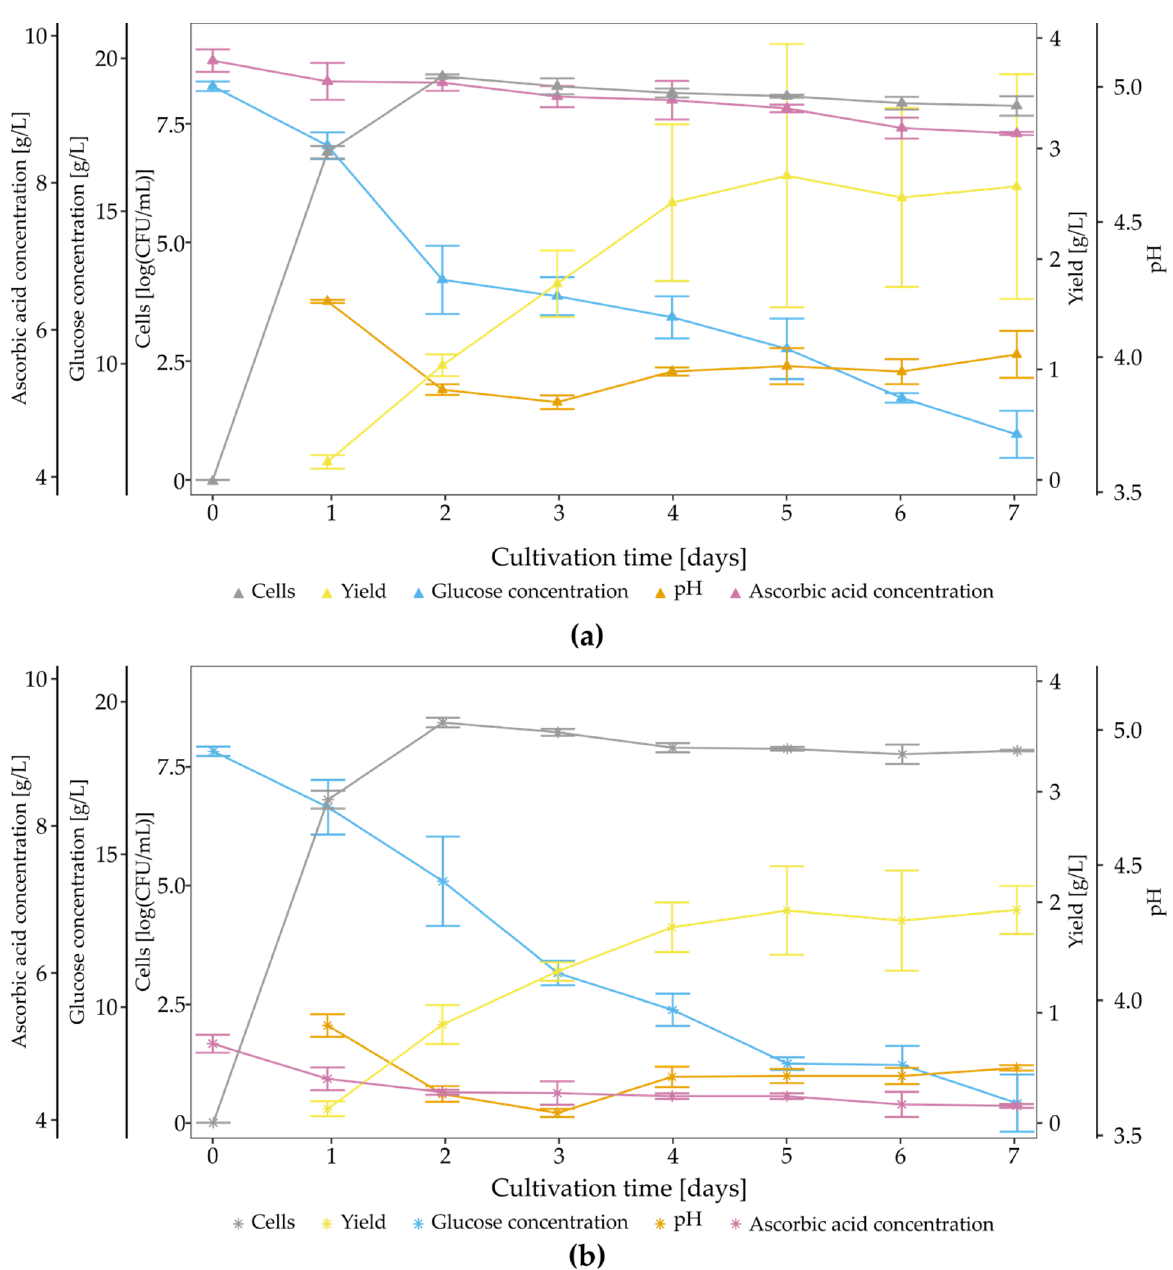
Figure 10. Time course of K. hansenii SI1 growth in ( a ) SH medium supplemented with 0.5% vitamin C and ( b ) SH medium supplemented with 1.0% vitamin C. Error bars represent standard deviation.